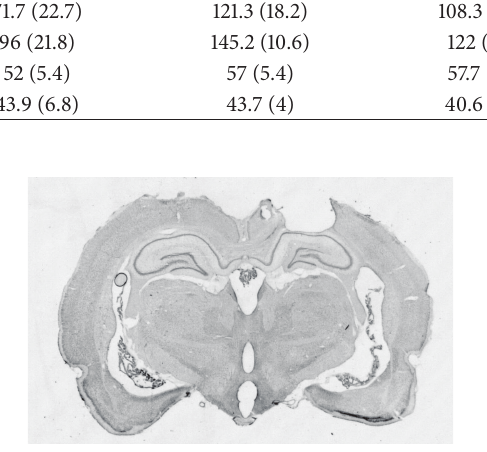
Figure 1: Representative lesion induced by